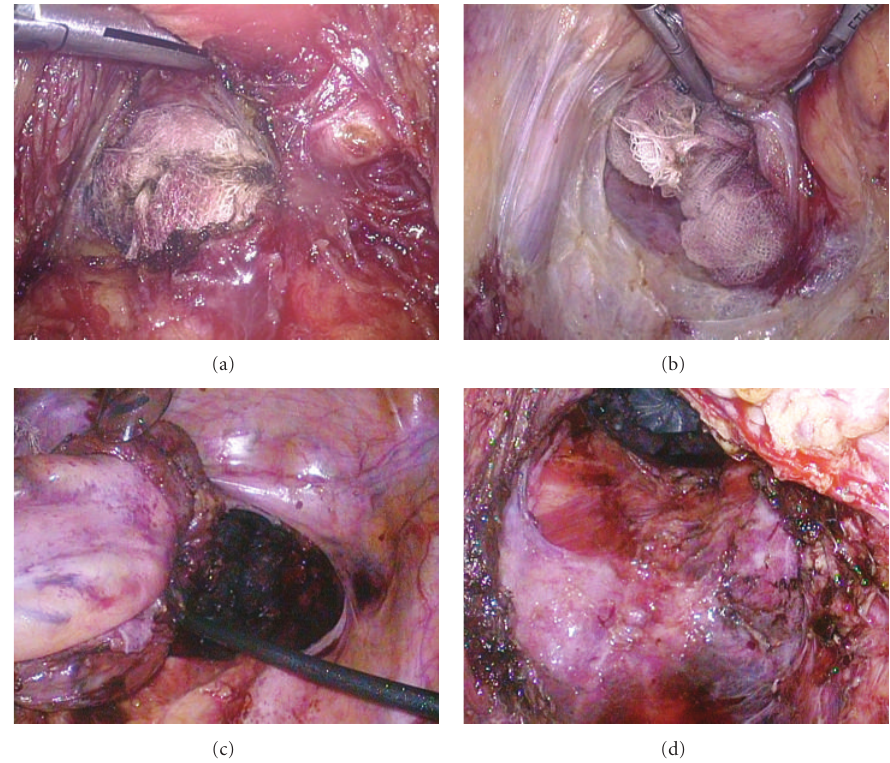
Figure 2: Laparoscopic procedure combined with transanal rectal dissection. The gauze that was placed on the dissected plane as a landmark was able to be identified through the peritoneum on the anterior side on the rectum. It was relatively easy to dissect Denonvillier’s fascia and expose the seminal vesicles and prostate gland (a). On the posterior side of the rectum, it was possible to mobilize the lower rectum and mesorectum from the sacrum on the separated plane between the visceral and parietal endopelvic fascia through the anus (b). The lateral ligaments of the rectum were gradually divided with a harmonic scalpel from the inner limit of the inferior hypogastric nerve fibers. The rectum, including the total mesorectum, was completely removed from the pelvic floor (c, d).